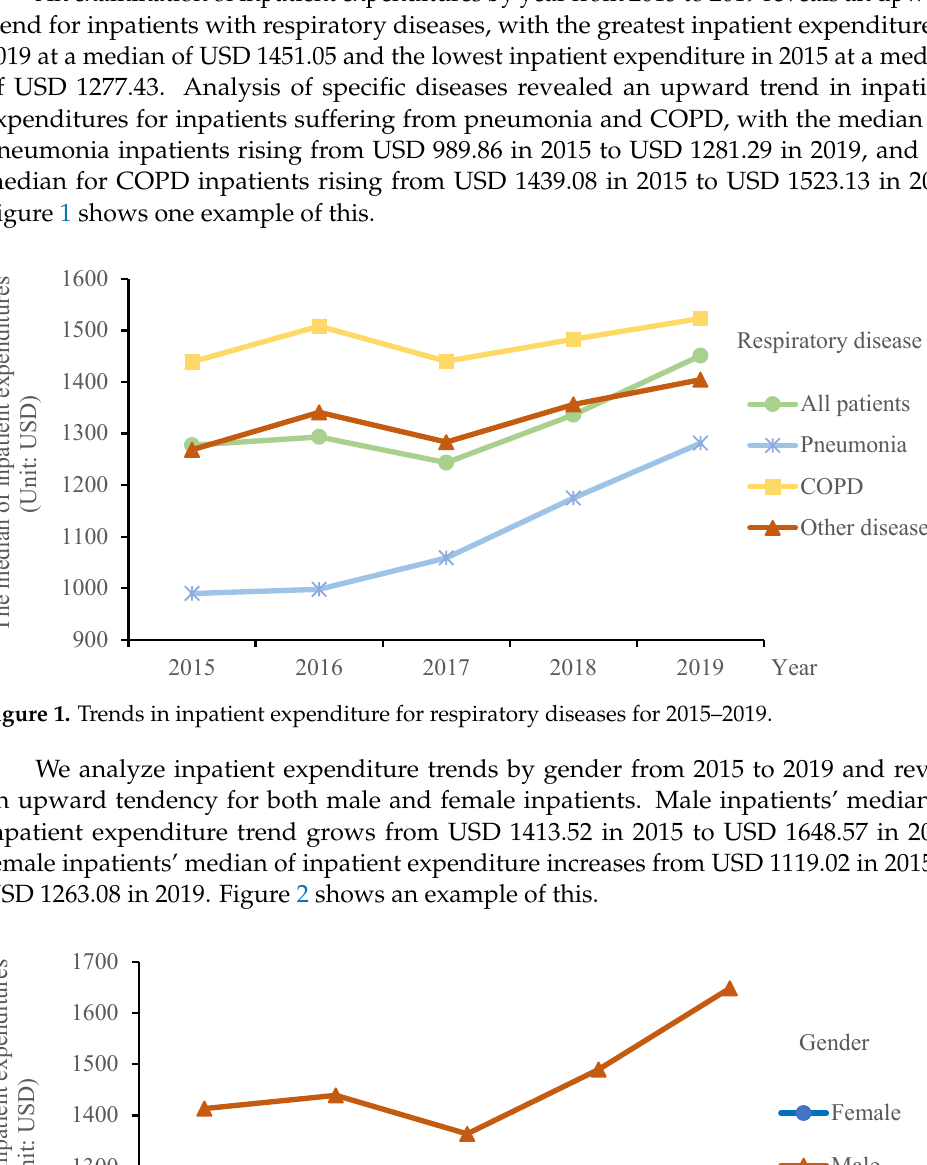
An examination of inpatient expenditures by year from 2015 to 2019 reveals an upward